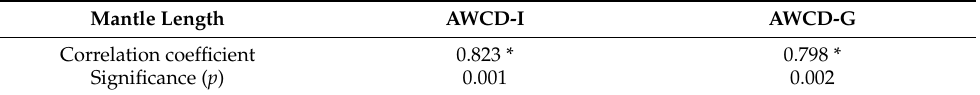
Figure 9. Variations in carbon source utilization by microbial communities of intestinal and gill tissues of dwarf-form squid. ( a ) Polymers, ( b ) Carboxylic acids, ( c ) Amino acids, ( d ) Carbohydrate, ( e ) Amines and ( f ) Others. Table 2. Correlation analysis between mantle length of the dwarf-form populations of Sthenoteuthis oualaniensis and the AWCD in the intestinal and gill bacterial community.